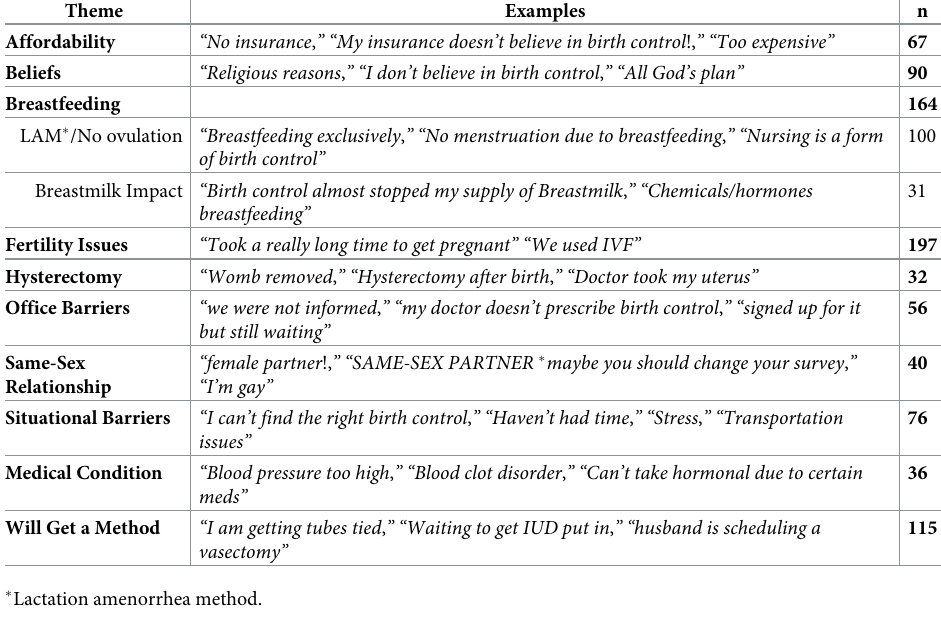
Table 2. Qualitative themes of postpartum contraception nonuse reasons among PRAMS Phase VII (2012)